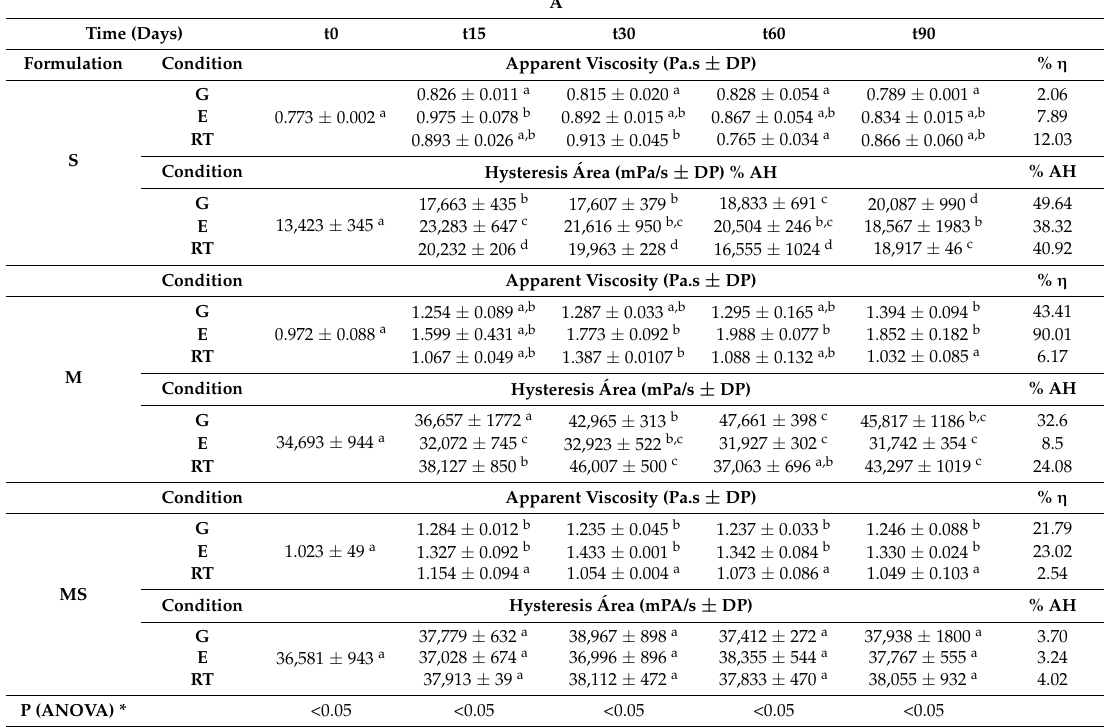
Table 5. Results for apparent viscosity at 200 s − 1 and hysteresis area of photoprotective formulations developed with cream base A with the addition of chemical and physical filters ( M ), rutin succinate ( S ) and rutin succinate + chemical filters and physical ( MS ) during Normal Stability